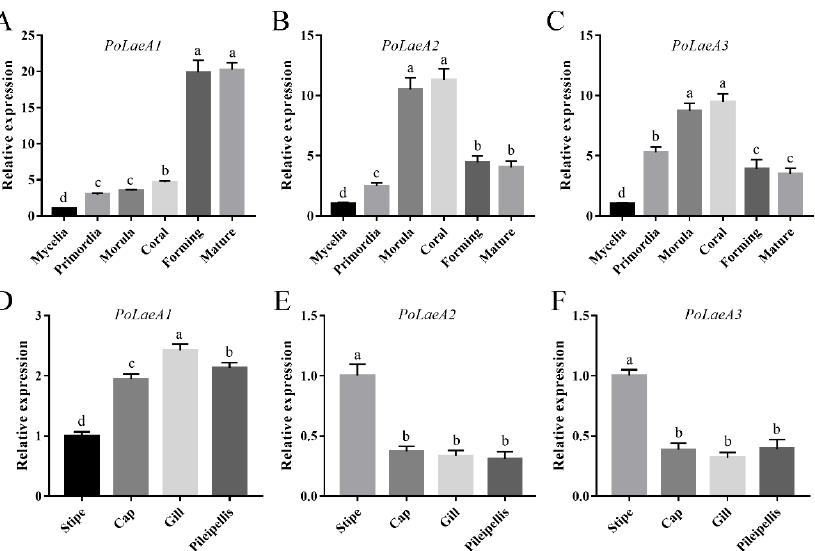
Figure 2. The expression of LaeA -like genes during different developmental stages and in different parts of fruiting bodies. ( A – C ) qRT – PCR analysis of LaeA -like gene expression in the WT strain during different developmental stages. The relative abundances of PoLaeA1 ( A ), PoLaeA2 ( B ) and PoLaeA3 ( C ) transcripts at different stages were normalized by comparison with those levels in the mycelial stage (relative transcript level =1.0). ( D – F ) Expression of LaeA -like genes in different parts of fruiting bodies. The relative abundances of PoLaeA1 ( D ), PoLaeA2 ( E ) and PoLaeA3 ( F ) transcripts in different parts of fruiting bodies were normalized by comparison with those levels in the stipe (relative transcript level =1.0). The values are the mean ± SD ( n = 3). Different lowercase letters indicate significant differences between the analyzed samples ( p < 0.05, according to Dunnett’s multiple comparisons test).